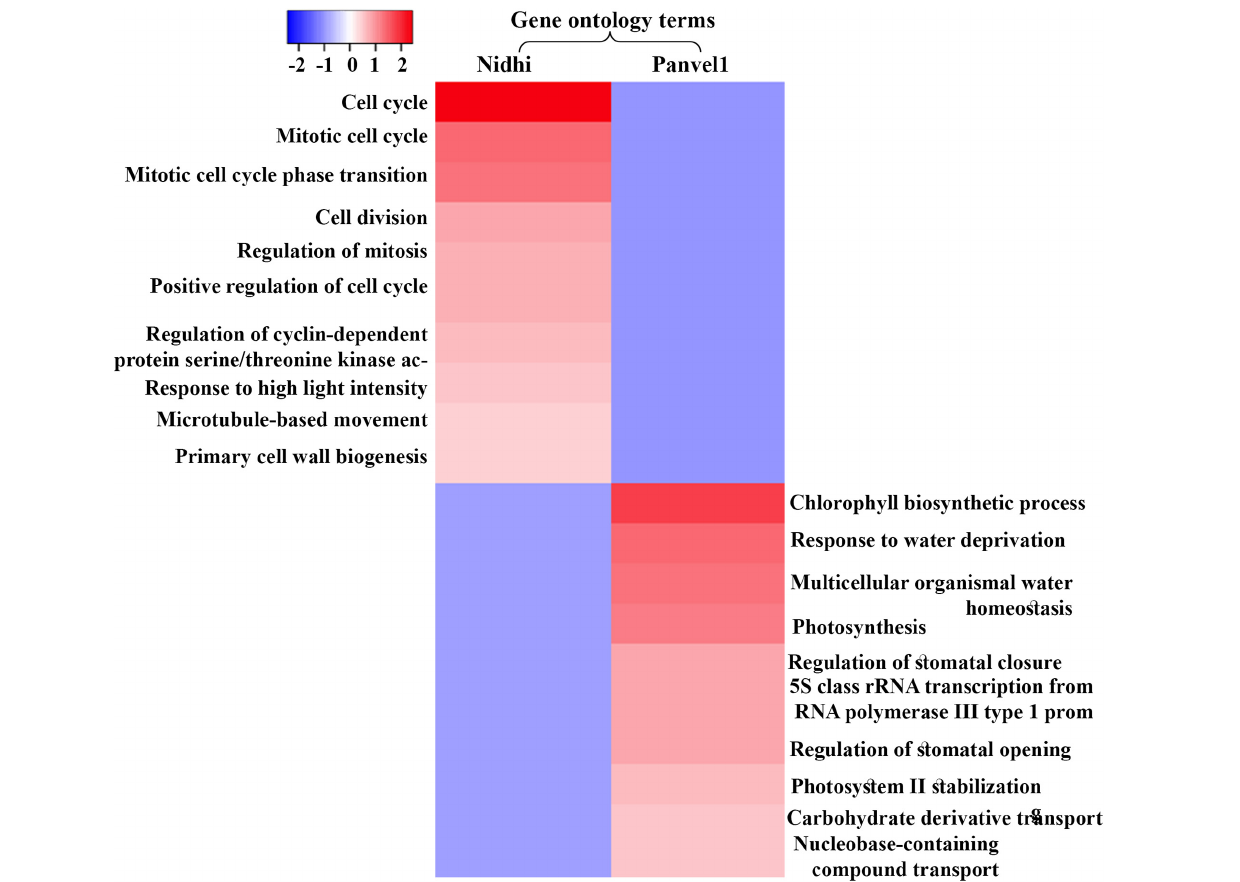
FIGURE 2 | Heat map was constructed using Heatmapper, which represents enriched top ten gene ontology (GO) terms (biological processes) for contrasting rice genotypes Nidhi and Panvel1. Minus log P values were plotted against the respective GO term.